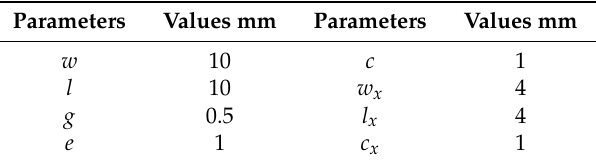
Table 1. Design parameters of the